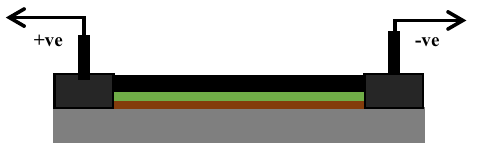
Figure 1. Schematic of a cross sectional view of a Pd/rGO gas